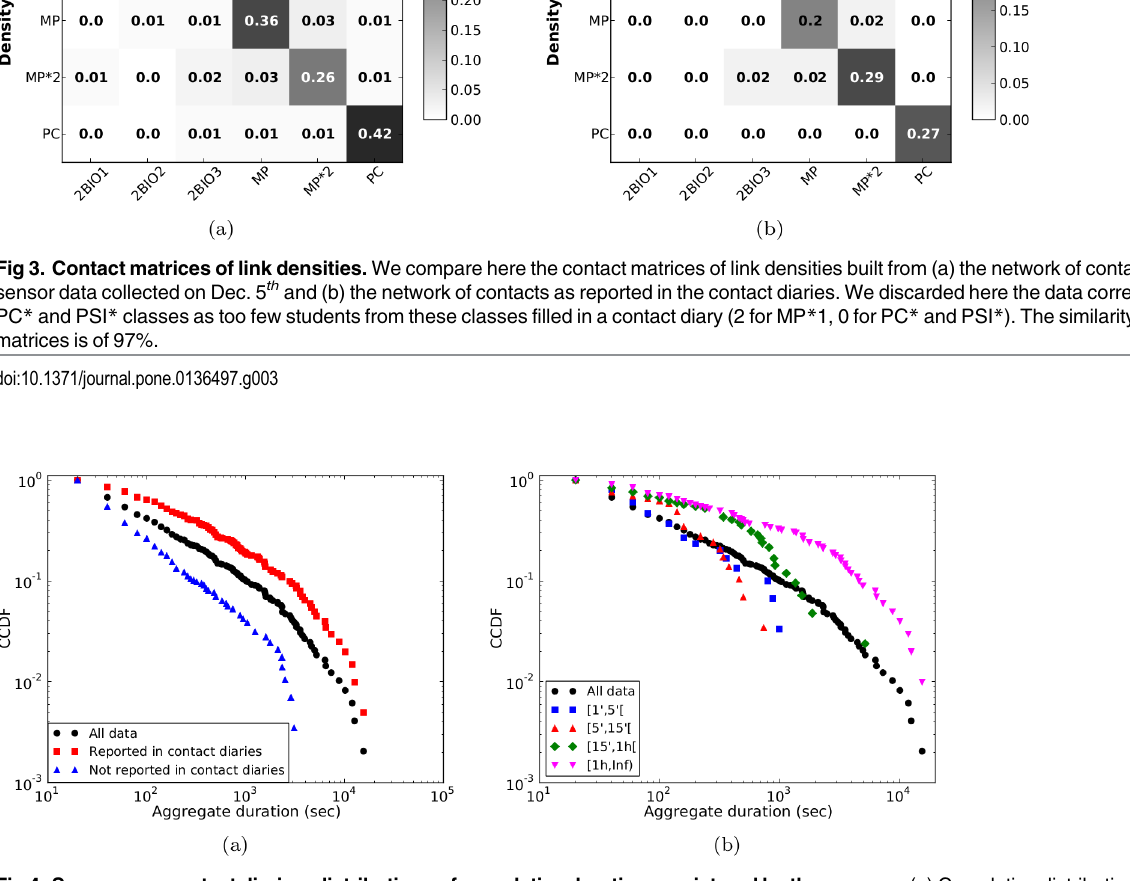
Fig 4. Sensors vs. contact diaries: distributions of cumulative durations registered by the sensors. (a) Cumulative distributions of the aggregate durations of contacts registered by the sensors for (i) all 488 links between the 109 nodes belonging to both networks; (ii) the 202 links that were also reported in the diaries; (iii) the 286 links that were not reported in the diaries. (b) Cumulative distribution of aggregate durations of contacts registered by the sensors for the different categories of links reported in the diaries.